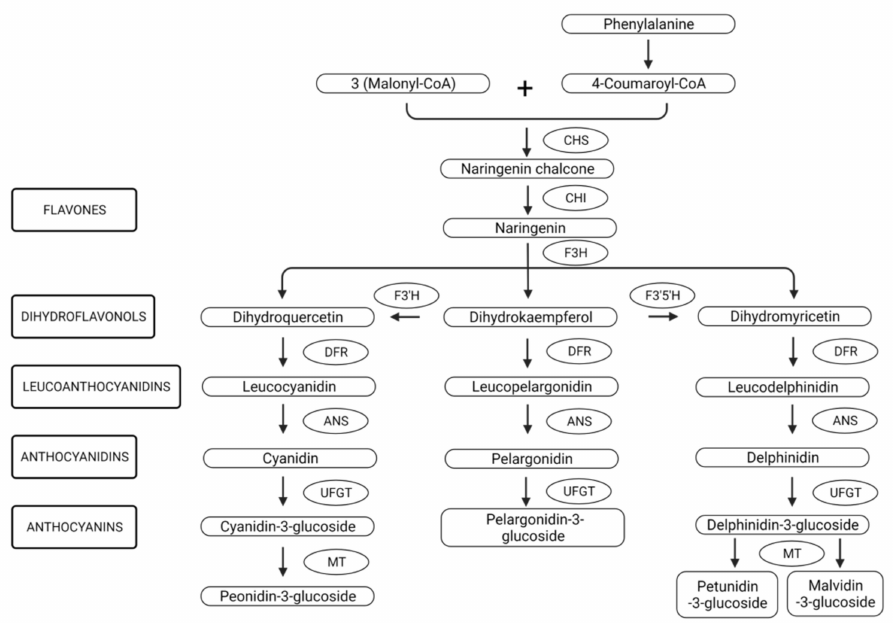
Figure 2. The biosynthesis pathway of ANs in plant cells. CHS: chalcone synthase, CHI: chalcone isomerase, F3H: flavanone 3-hydroxylase, F3 (cid:48) H: flavonoid 3 (cid:48) -hydroxylase, F3 (cid:48) 5 (cid:48) H: flavonoid 3 (cid:48) ,5 (cid:48) -hydroxylase, DFR: dihydroflavonol 4-reductase, ANS: anthocyanidin synthase, UFGT: flavonoid 3-O-glucosyltransferase, MT: O-methyl transferase (original